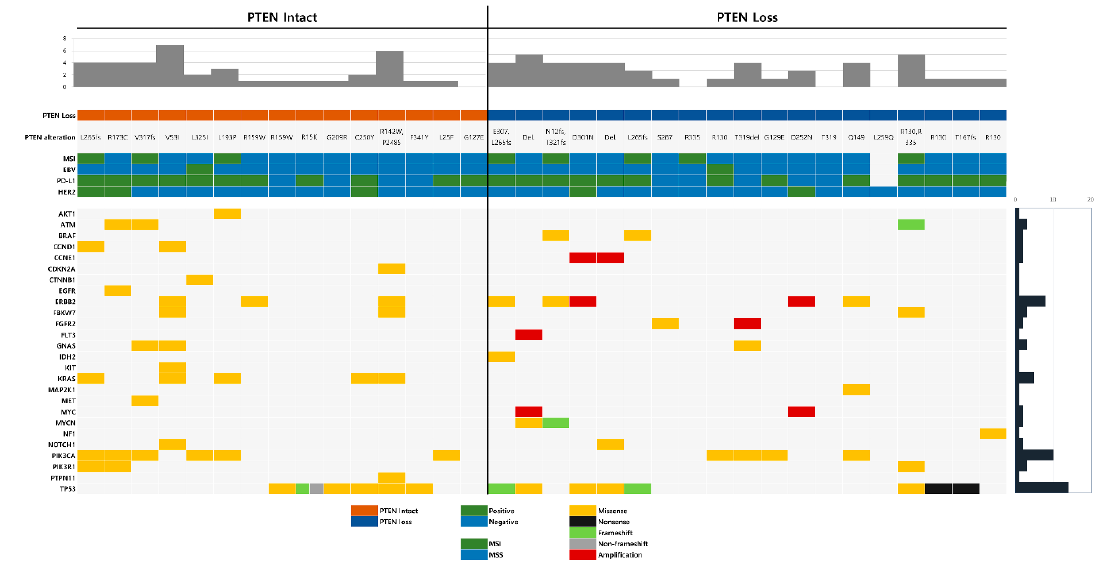
Figure 2. The distribution and prevalence of co-occurring genetic alterations associated with phosphatase and tensin homolog ( PTEN ), microsatellite instability (MSI) status, Epstein–Barr virus (EBV), HER2, and PD-L1.